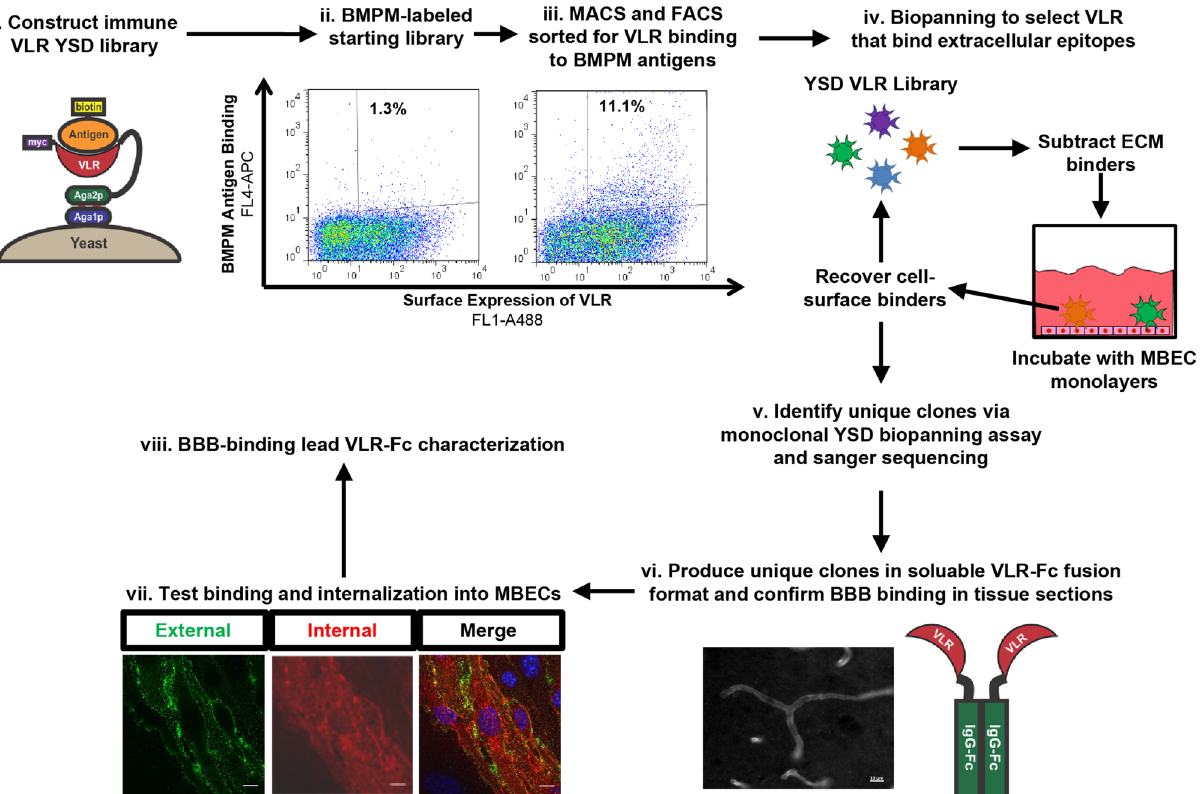
Figure 2. BBBVLR library screening and characterization workflow. (i) Immunized lamprey BBBVLR libraries are expressed on the yeast surface by fusion to the C-terminus of the Aga2p protein. Each yeast cell displays thousands of copies of a single VLR clone on its surface. (ii) and (iii) The immune, unsorted library is enriched for binders to BBB antigens expressed in vivo via MACS and FACS with detergent-solubilized BMPMs. The percentage of antigen-binding yeast clones before (ii) and after (iii) sorting are reported. (iv) The FACS- enriched BMPM-binding pool is next screened for VLRs that bind extracellular domains of BMPM epitopes